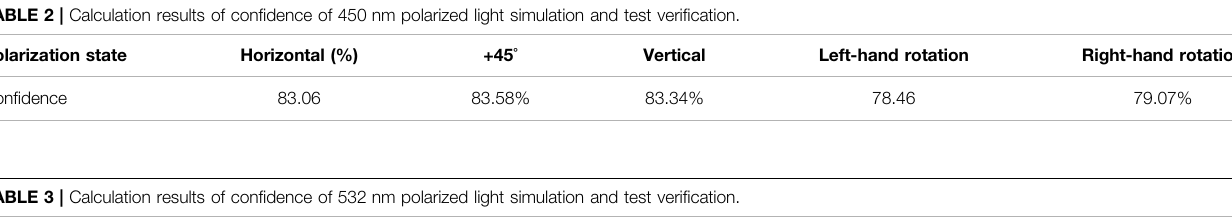
TABLE 3 | Calculation results of con fi dence of 532 nm polarized light simulation and test veri fi cation. Polarization